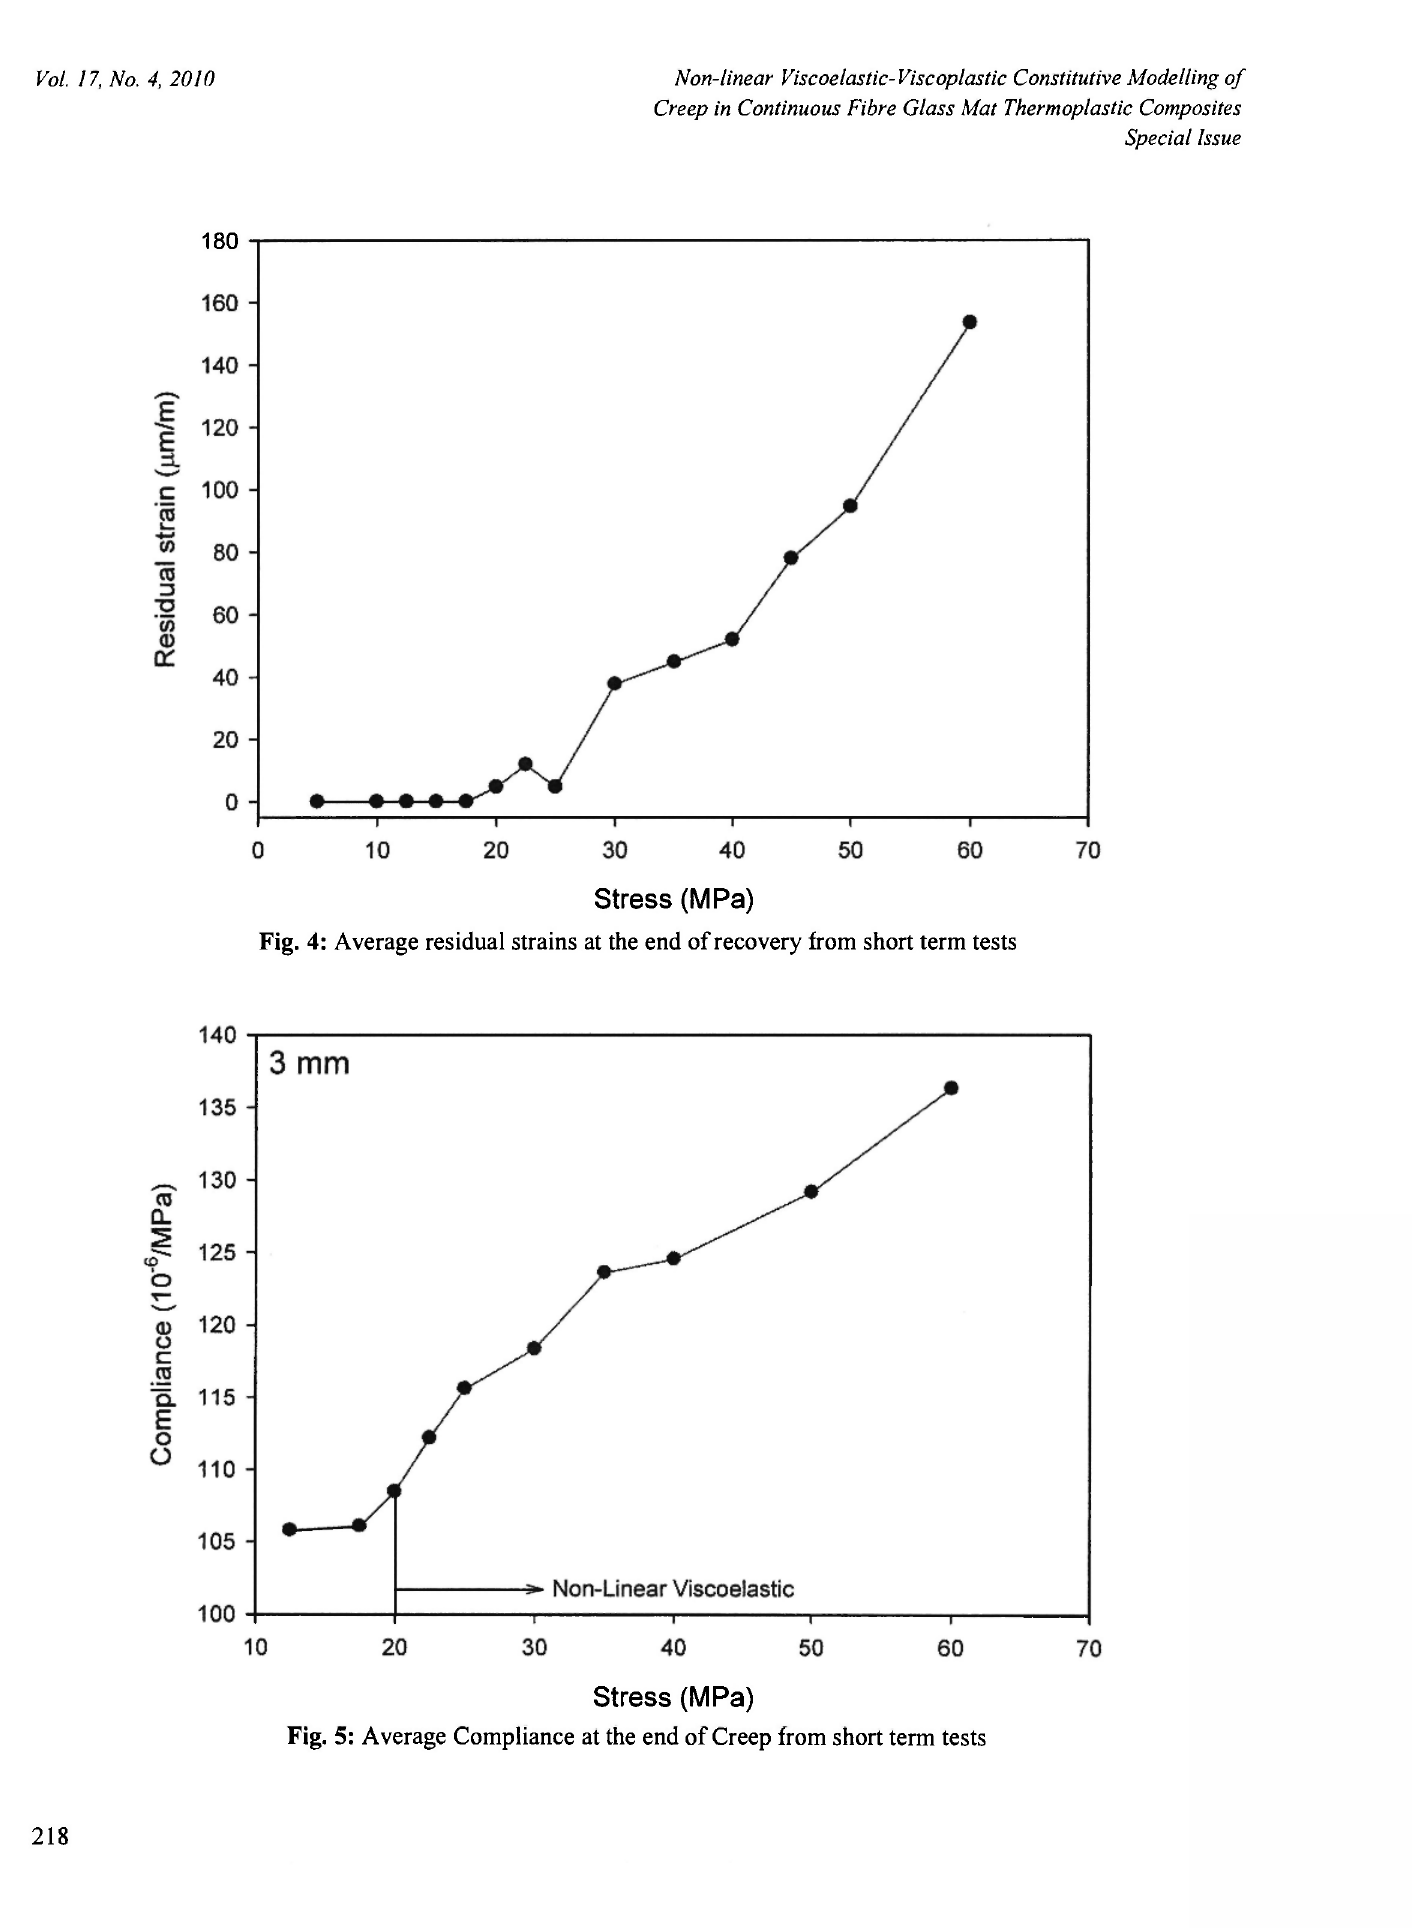
Fig. 5: Average Compliance at the end of Creep from short term